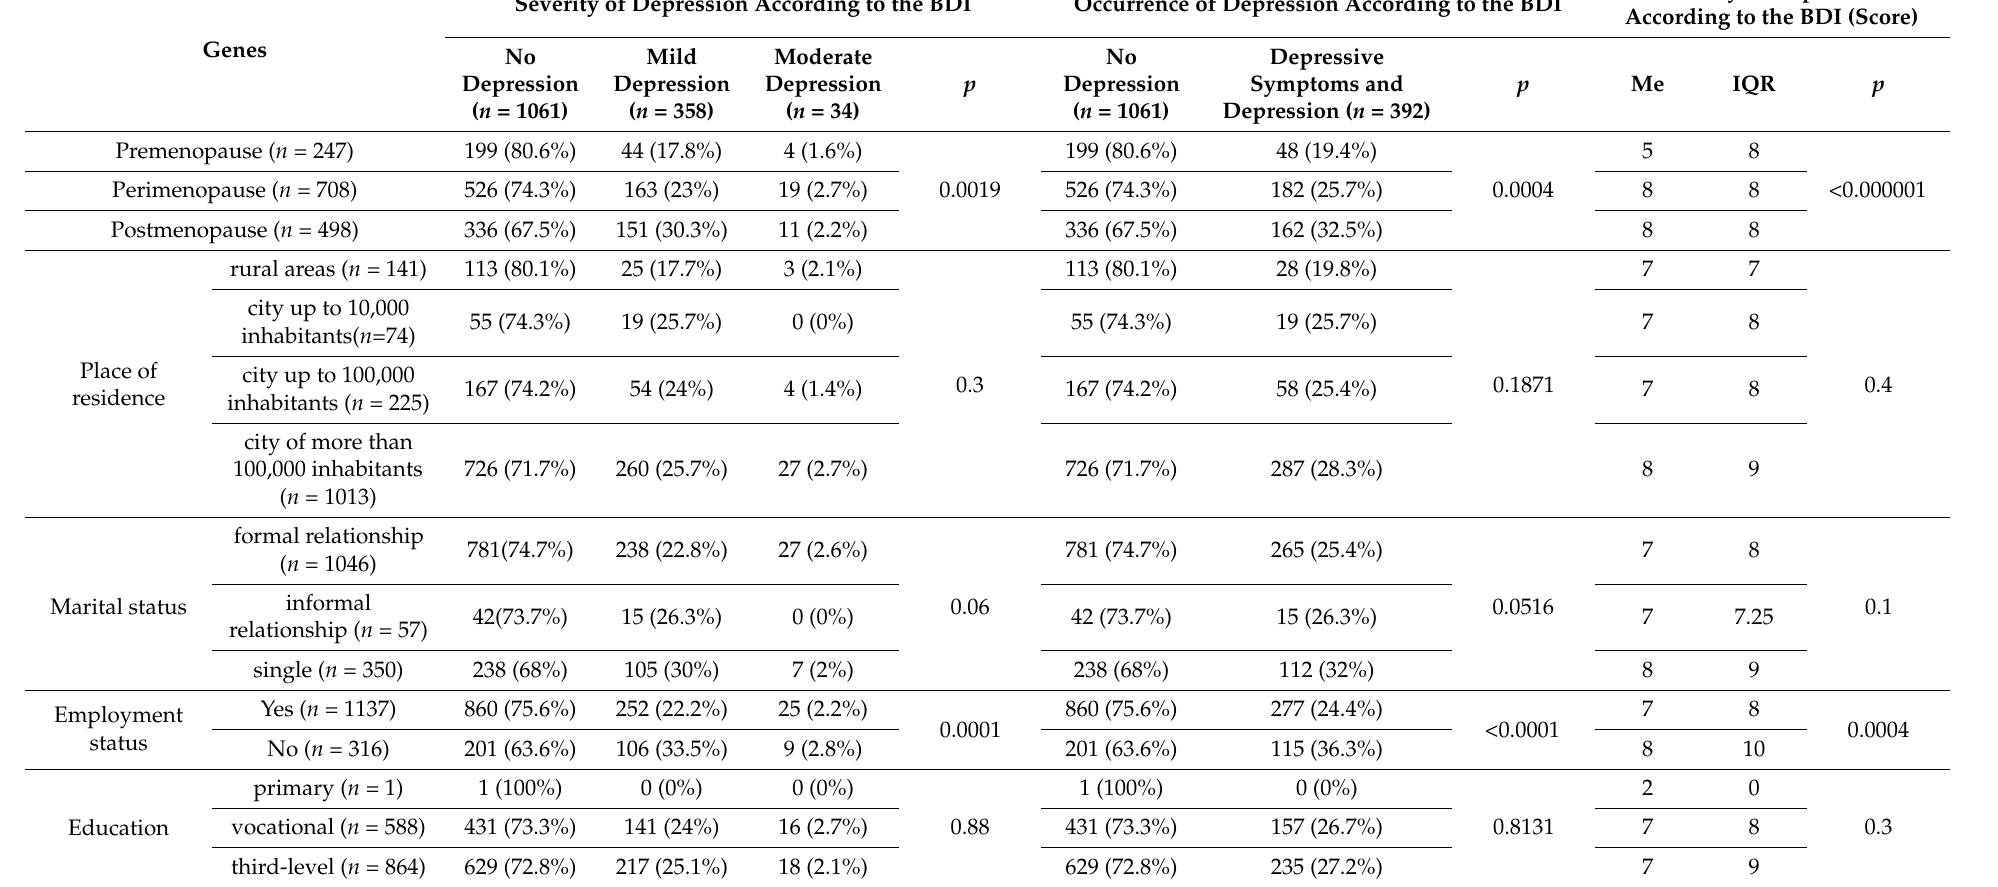
Severity of Depression According to the BDI